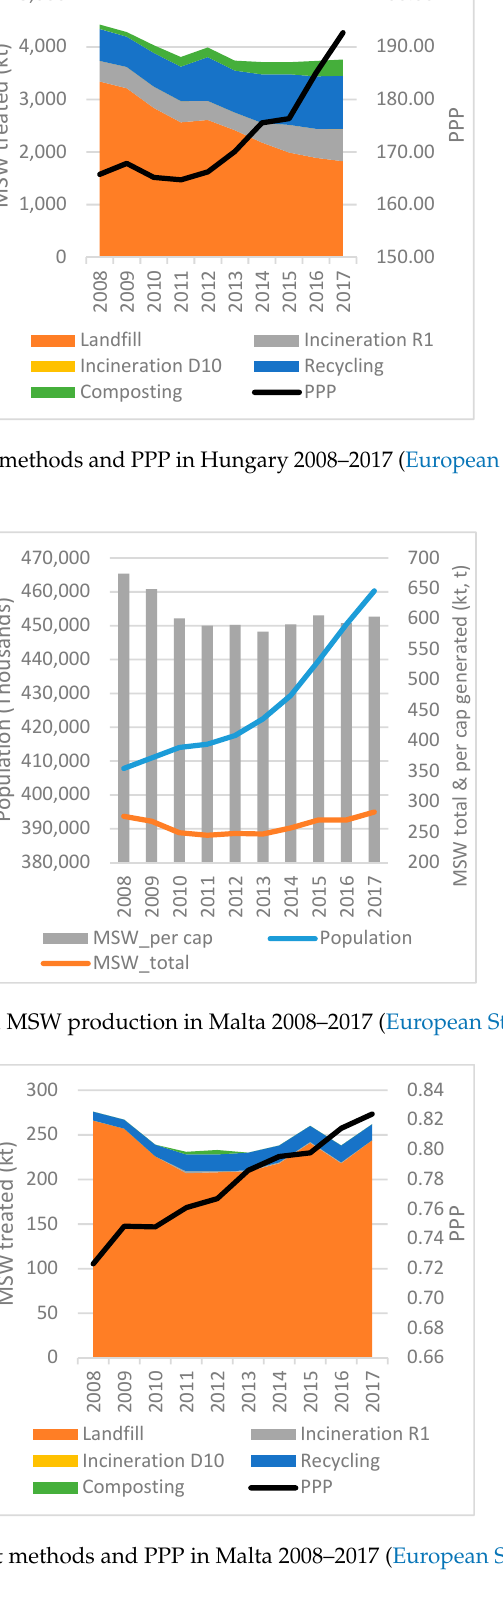
Figure 34. Waste treatment methods and PPP in Hungary 2008–2017 (EUROSTAT 2019b, 2019c).